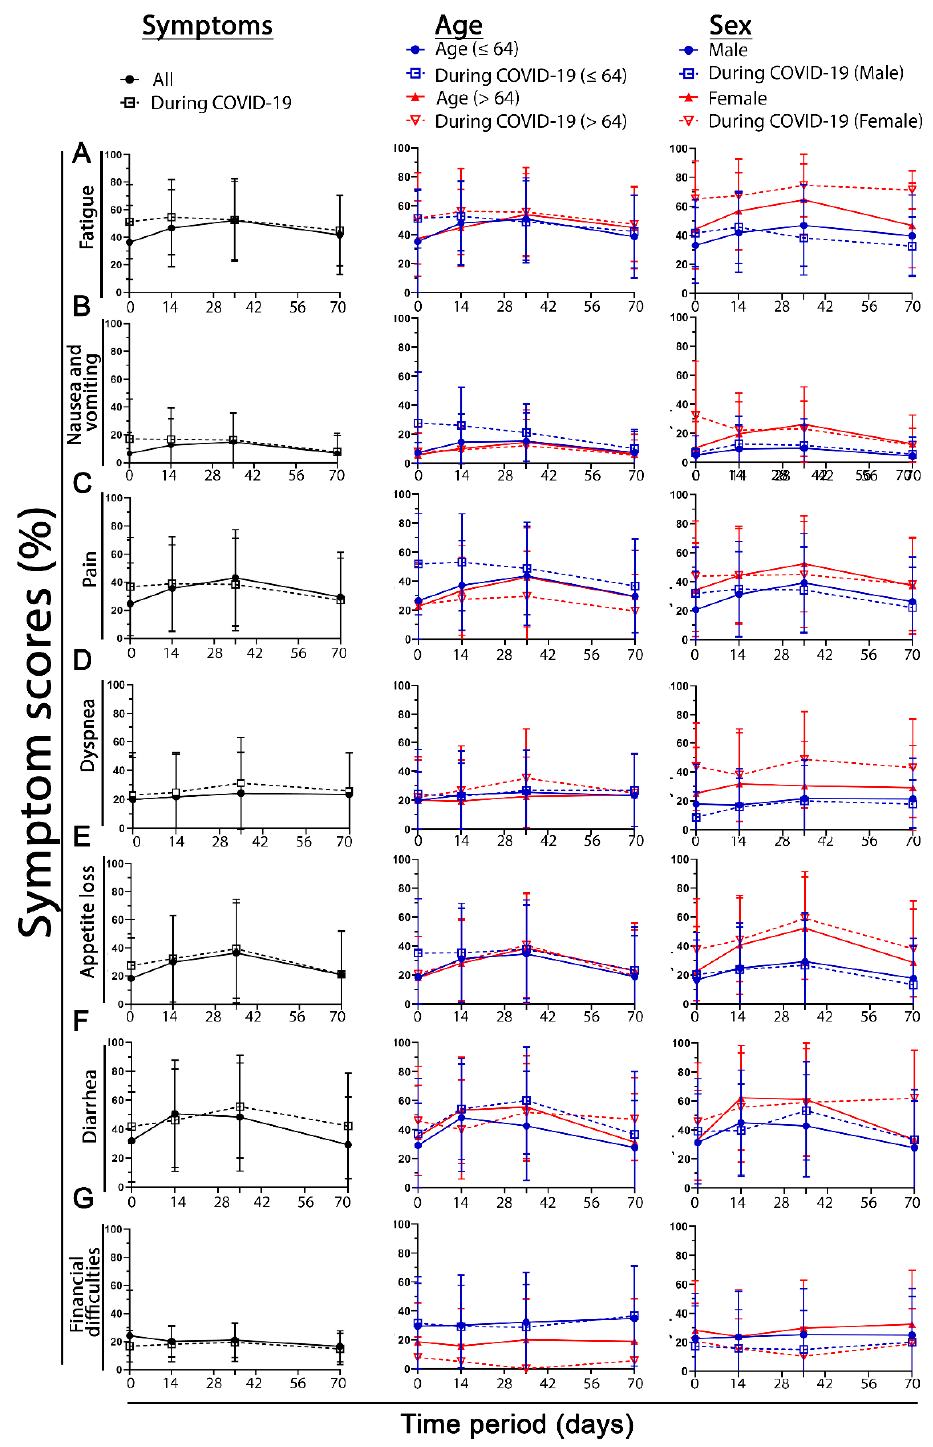
Figure 7 . Time course of different symptom scores at day 1, day 14, day 35 and day 70. In the first column the entire cohort is separated into normal (before COVID-19) and during COVID-19. In the second column the cohort was divided into patients younger or 64 to older than 64. In the third column females and males of the cohort were compared for ( A ) fatigue, ( B ) nausea and vomiting, ( C ) pain, ( D ) dyspnea, ( E ) appetite loss, ( F ) diarrhea, and ( G ) financial difficulties at the different time periods at which the surveys took place, at day 1, day 14, day 35, and day 70. Error bars indicate the standard deviation.